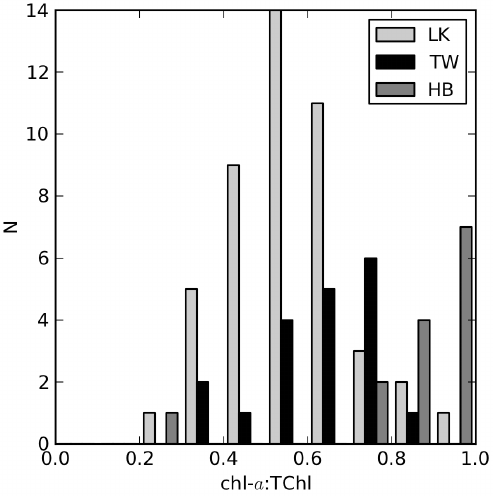
Figure 15. Frequency distribution of the chl- a to TChl (chl- a + pheo) ratio for each